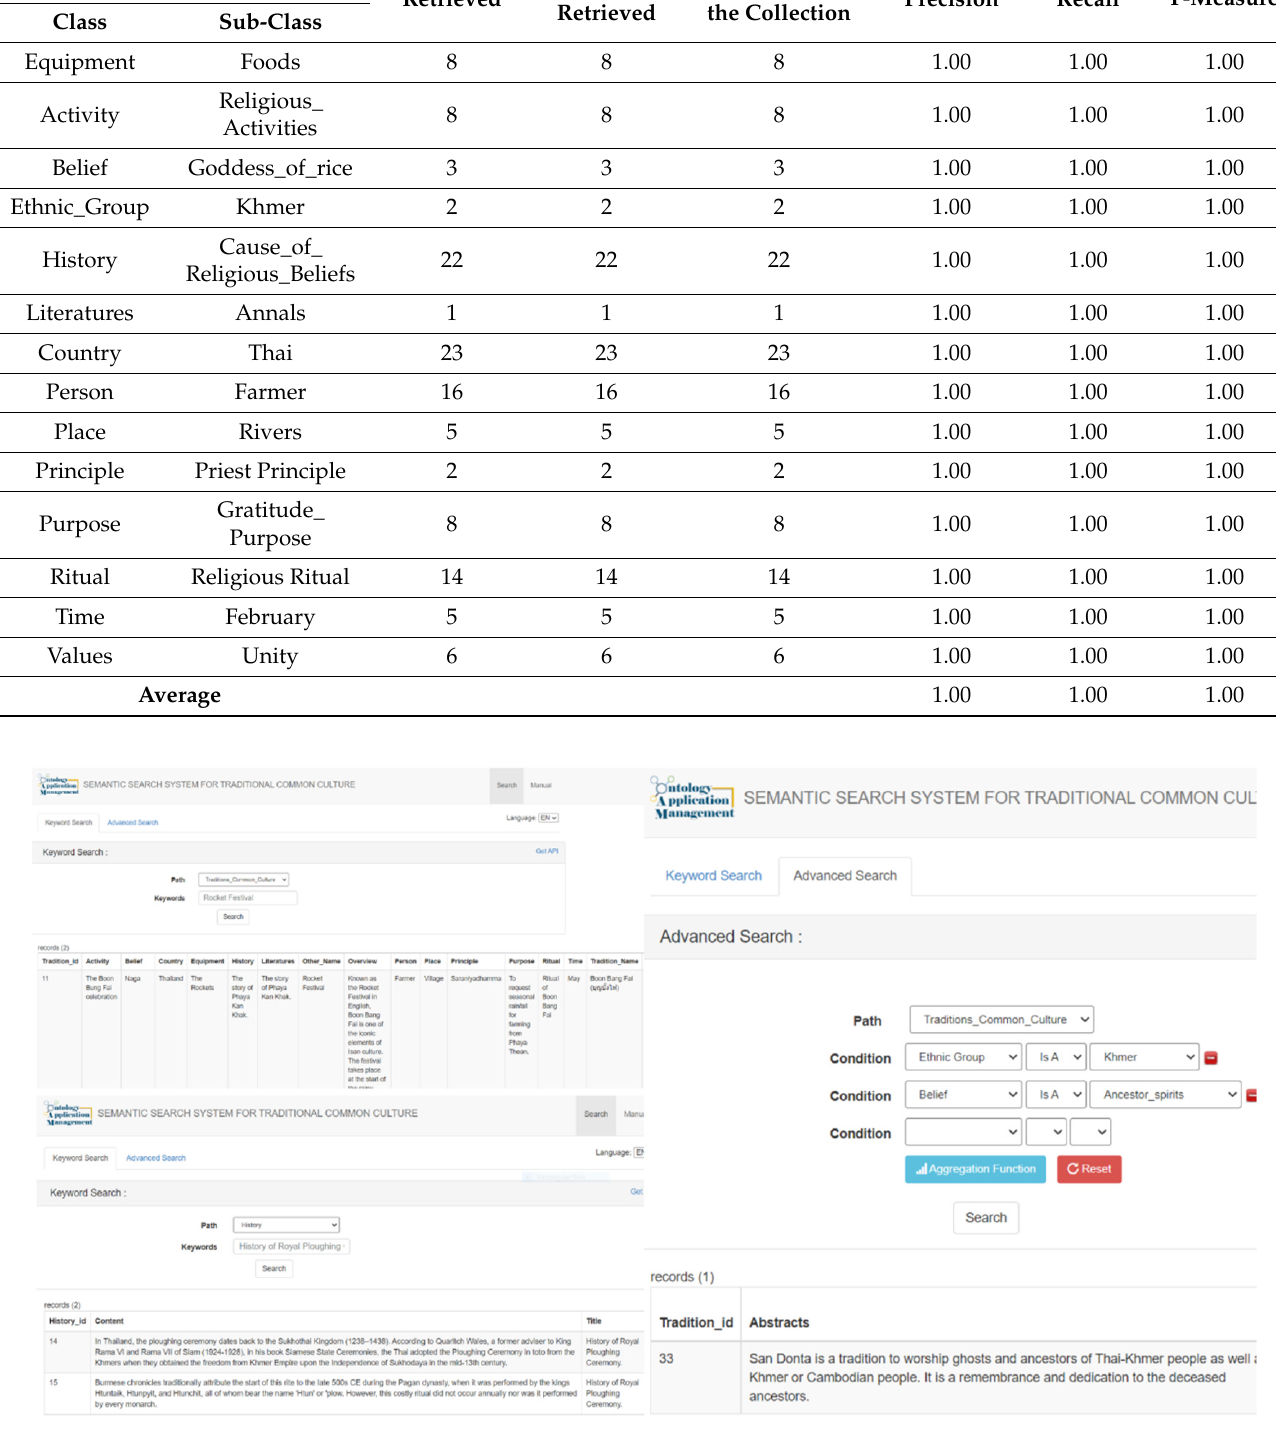
Figure 4. The prototype of the semantic search system using ontology. As can be seen in Table 5, the results of the advanced search performance evaluation showed a mean F-measure of 1.00. This indicates that the semantic search system developed Table 4. The performance of the semantic information retrieval system with keyword search. from this ontology knowledge base has high browsing